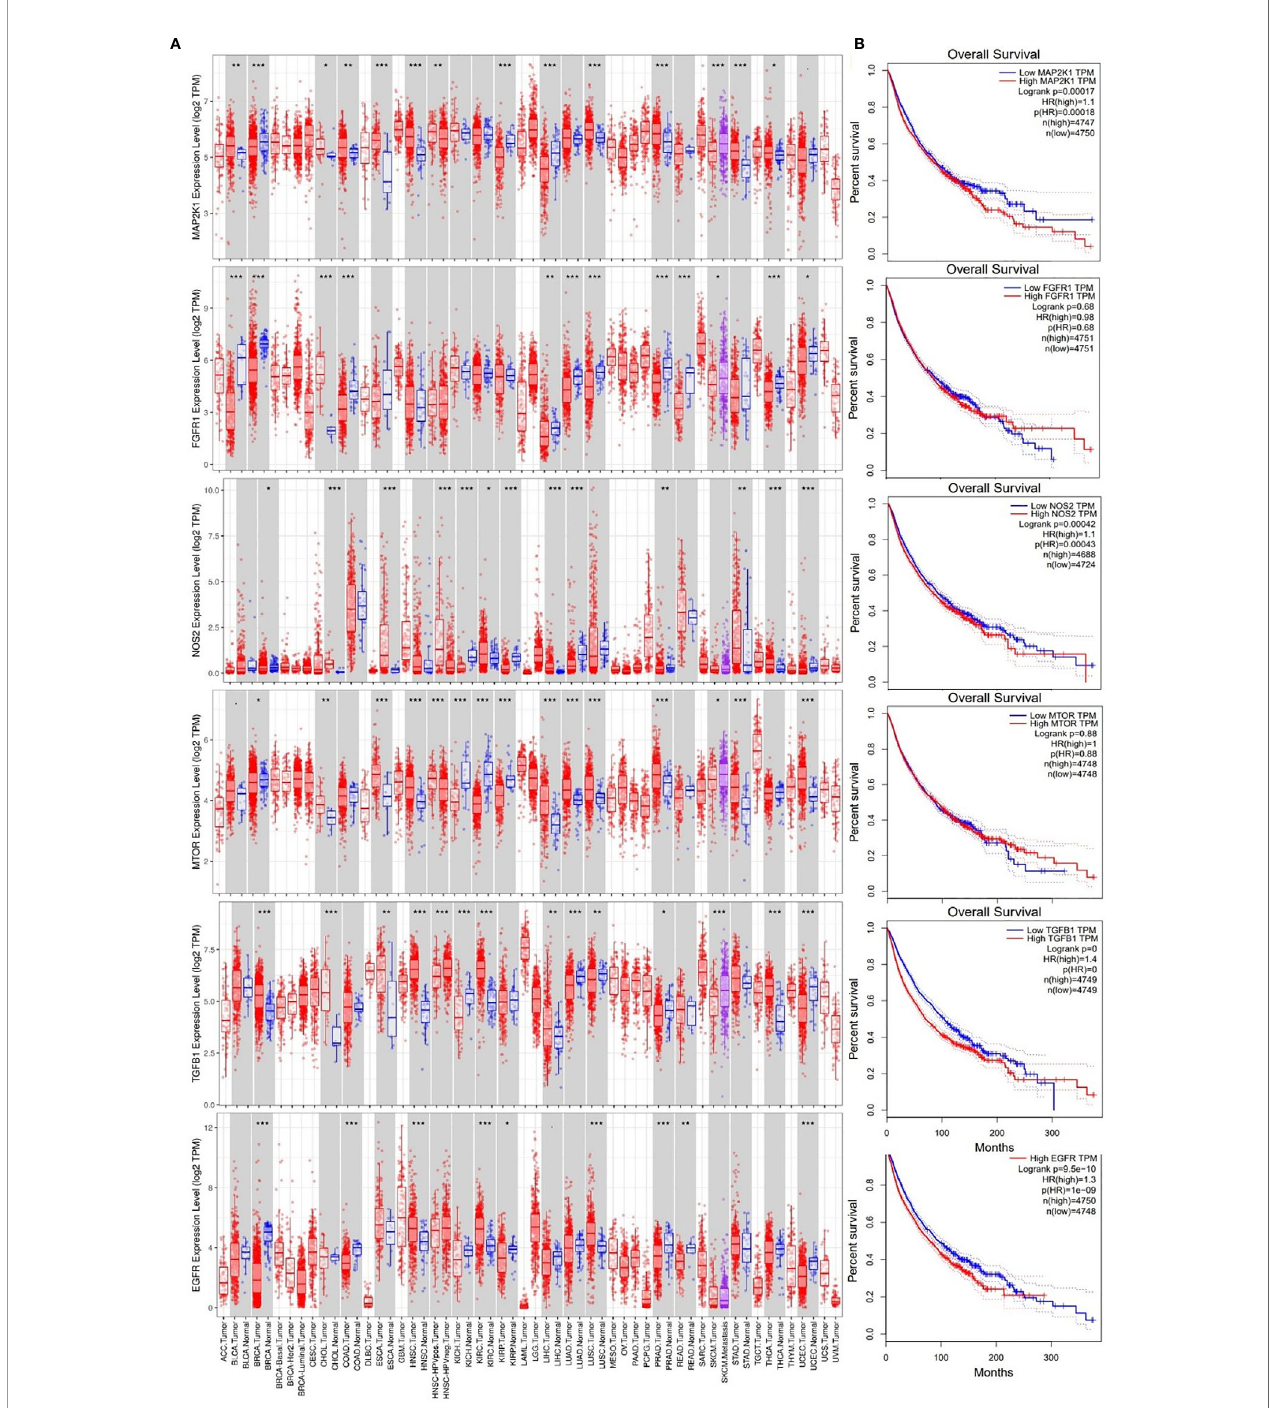
FIGURE 4 | Expression levels and prognostic values of epidermal growth factor receptor (EGFR), mammalian target of rapamycin (mTOR), nitric oxide synthase 2 (NOS2), transforming growth factor- b 1 (TGFB1), mitogen-activated protein 2 kinase 1 (MAP2K1), and fi broblast growth factor receptor 1 (FGFR1) in The Cancer Genome Atlas (TCGA) cancer cohorts. (A) Box plots showing differential gene expression levels (log2 TPM) of signal transduction and activator of transcription 3 (STAT3)/cyclin-dependent kinase 2 (CDK2)/4/6 between tumor and adjacent normal tissue samples across TCGA database. Blue labels indicate normal tissues, and red labels indicate tumor samples. (B) Kaplan-Meier curve of overall survival of cancer cohorts with low and cohorts with high RNA expression levels of EGFR, mTOR, NOS2, TGFB1, MAP2K1, and FGFR1. Higher RNA expression pro fi les of MAP2K1/NOS2/EGFR were correlated with low overall survival of cohorts. The statistical signi fi cance of differentially expressed genes was evaluated using the Wilcoxon test. * p <0.05; ** p <0.01; *** p